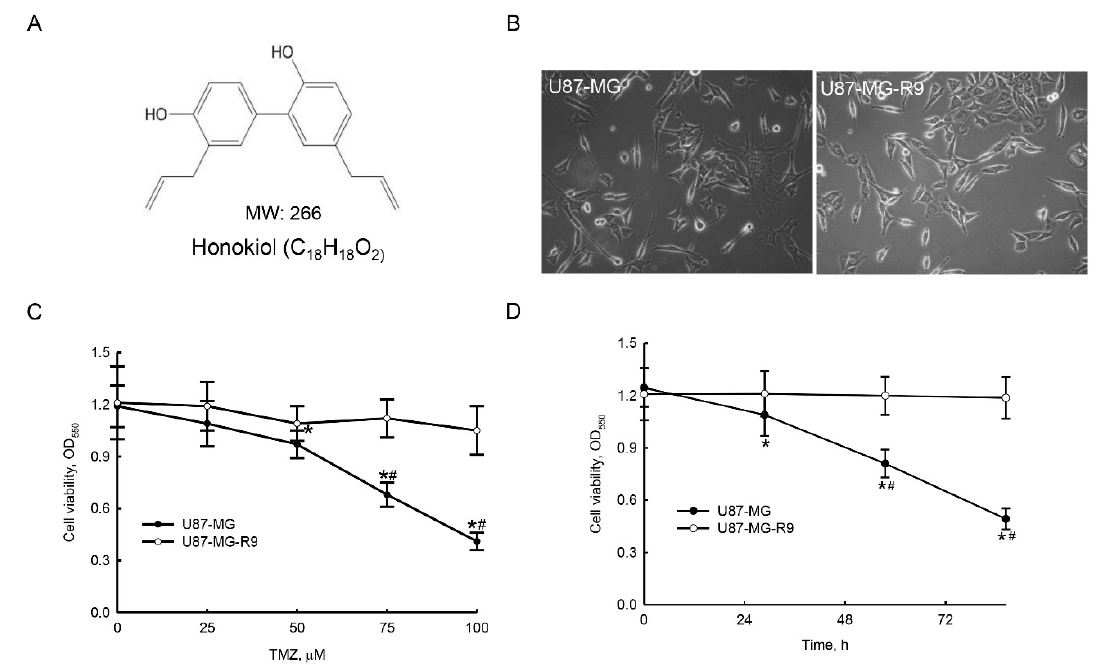
Figure 2. Selection of human drug-resistant glioblastoma cells. Chemical structure and molecular weight (MW) of honokiol is shown ( A ). Human temozolomide (TMZ)-resistant U87-MG-R9 glioblastoma cells were prepared by selection from human U87-MG cells. Morphologies of U87-MG and U87-MG-R9 cells are shown ( B ). Exposure of U87-MG and U87-MG-R9 cells to 25, 50, 75, and 100 μ M TMZ for 72 h ( C ) or 100 μ M TMZ for 24, 48, and 72 h ( D ). Cell viability was assayed using a colorimetric assay. Each value represents the mean ± SD for at least three independent determinations. The symbols * and # indicates that the value significantly ( p < 0.05) differs from the control and drug-resistant cells, respectively.